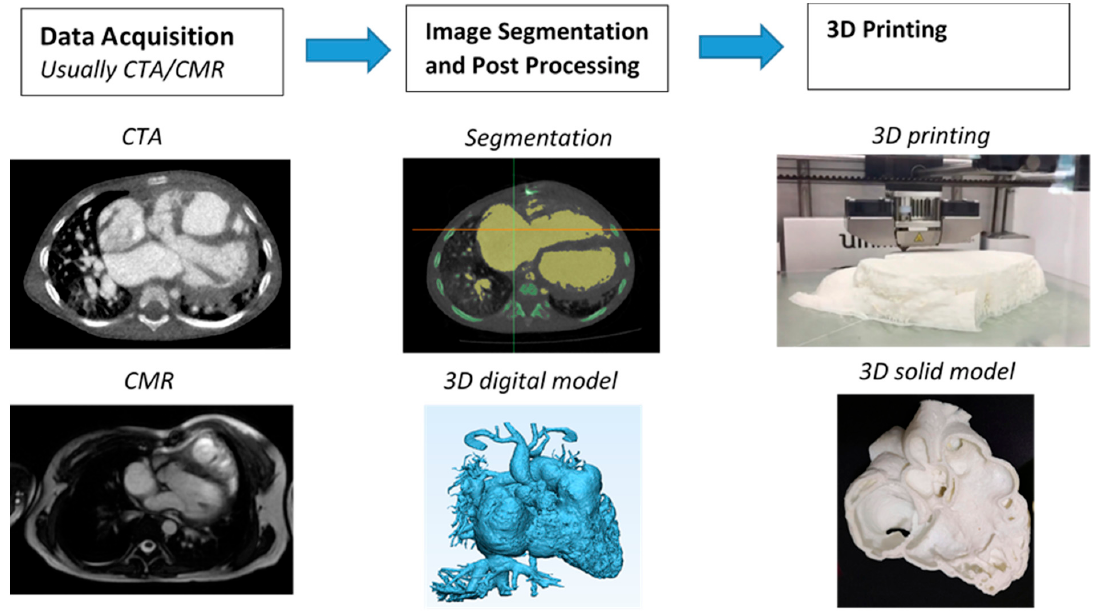
Figure 1. Steps involved in fabrication of 3D printed heart models. CTA—computed tomography angiography; CMR—cardiac magnetic resonance; 3D—three-dimensional.